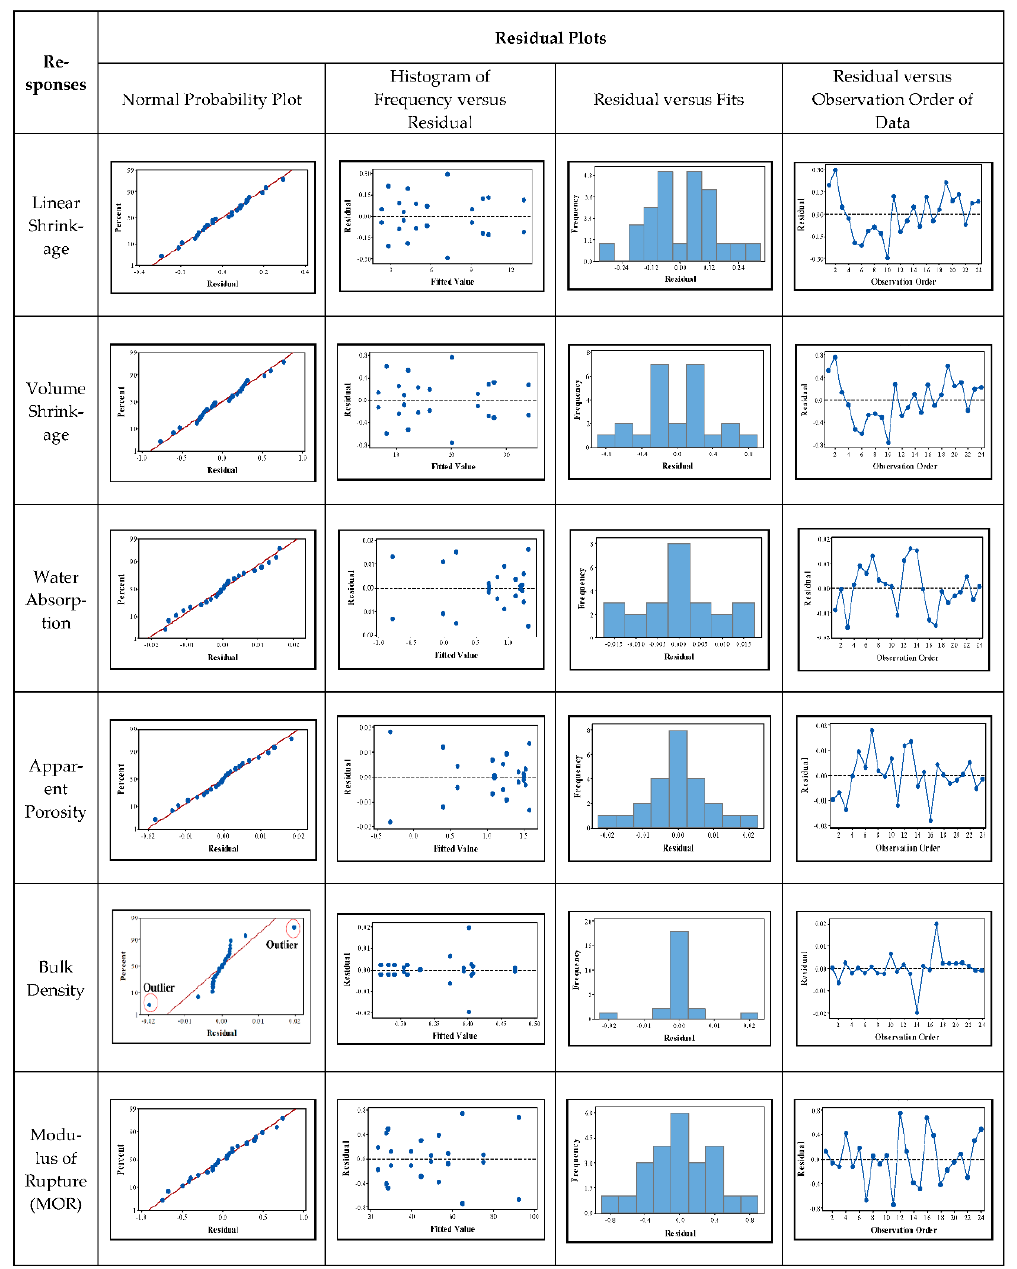
Figure 1. Residual plots of model adequacy checking for linear shrinkage, volume shrinkage, water absorption, apparent porosity, bulk density, and MOR.